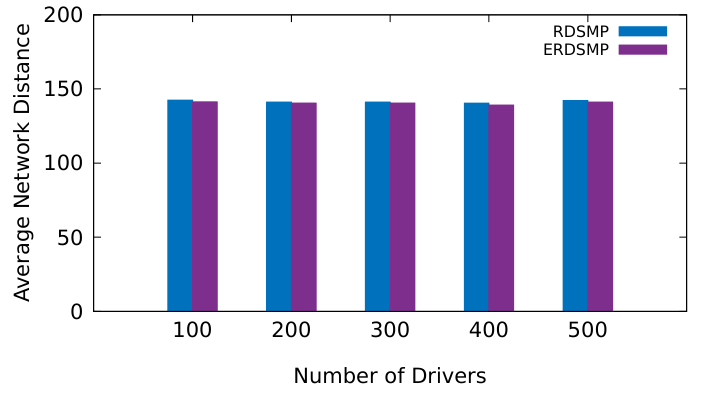
Figure 6. Average distance for different number of drivers.